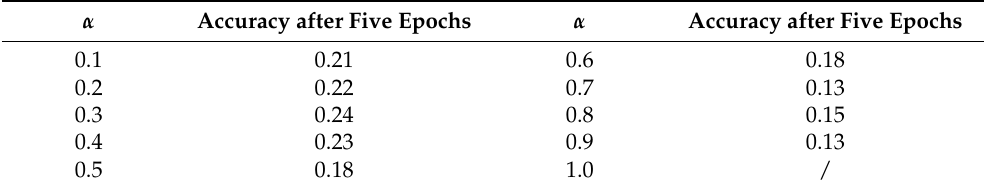
Table 2. Influence of different values of α on the accuracy of the model.